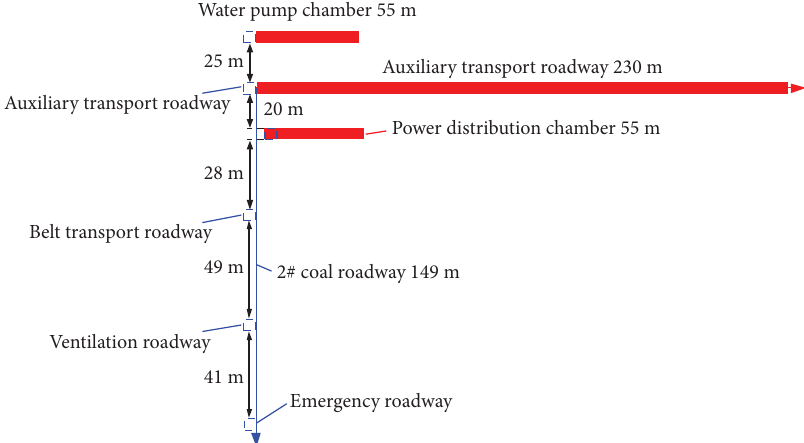
Figure 4: Schematic diagram of location relationship between 3# coal chamber and 2# coal roadway.